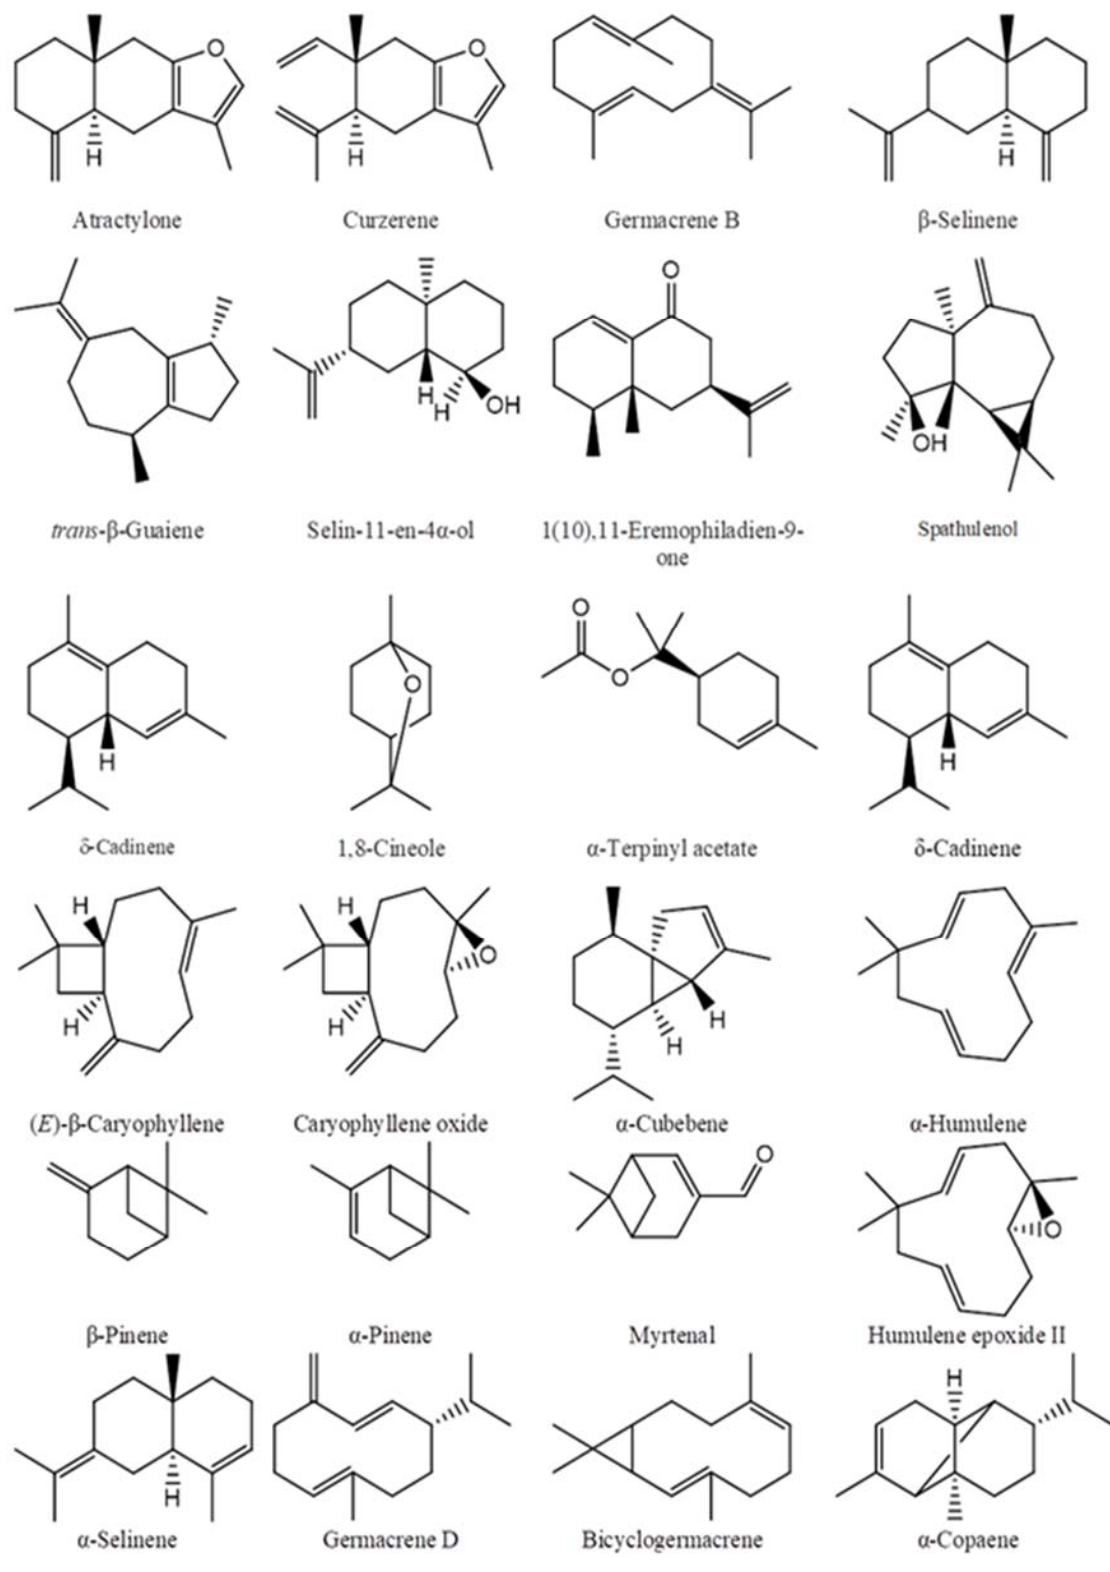
Figure 1. The main chemical components of essential oils.